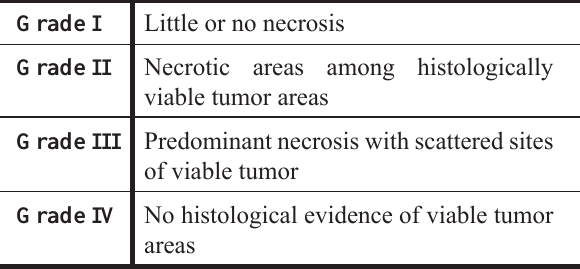
TABLE 1 - Post-chemotherapy evaluation